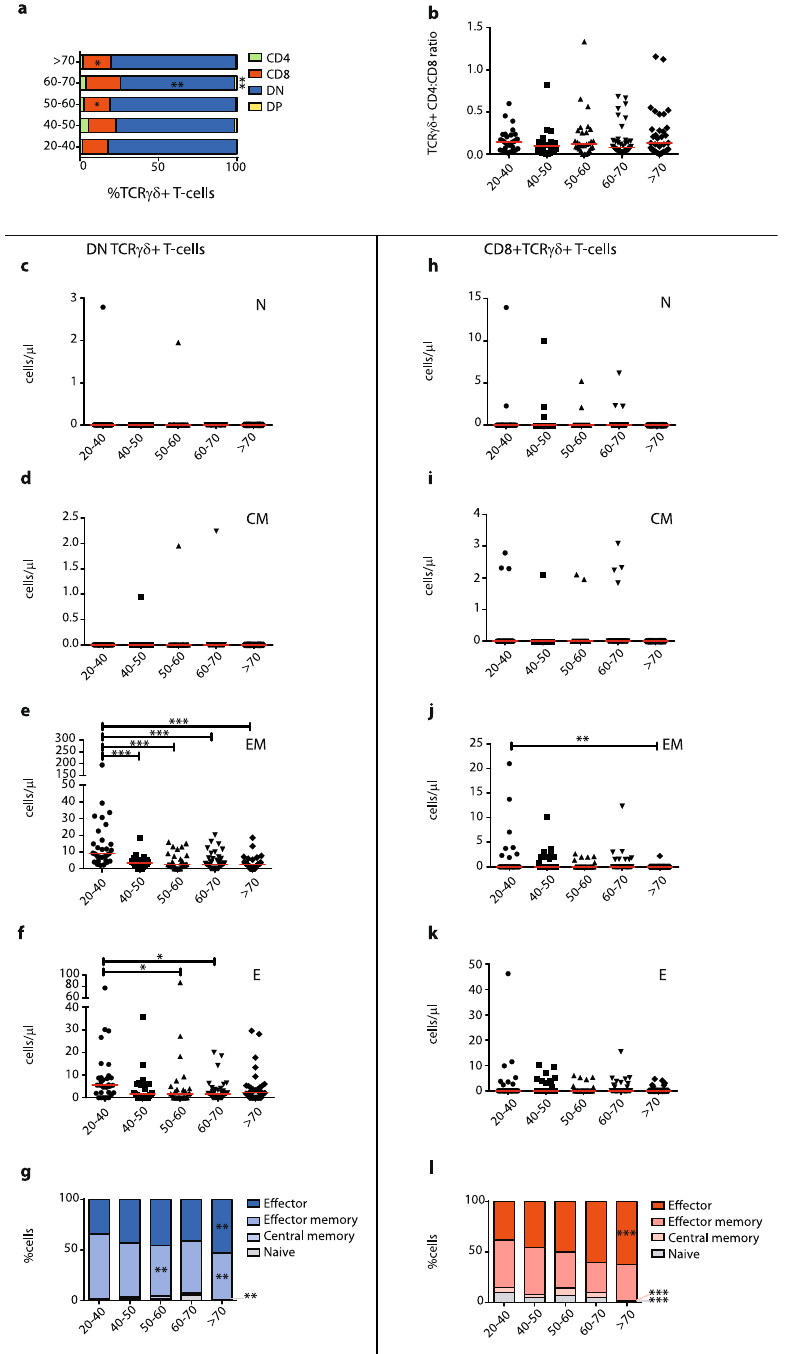
Figure 2. TCR γδ+ T-cell maturation statuses and subset distributions during ageing. ( a ) Relative visualization of CD4 and CD8 single-positive, double-positive (DP, CD4 + CD8 + ) and double-negative (DN, CD4 − CD8 − ) distribution within the total TCR γδ+ T-cell compartment between different age groups. ( b ) CD4:CD8 ratios in total TCR γδ+ T-cell population. ( c ) Absolute numbers of DN naive (CD45RO − CD197 + ), ( d ) central memory (CD45RO + CD197 + ), ( e ) effector memory (CD45RO + CD197 − , Temro) and ( f ) effector (CD45RO − CD197 − , Temra) TCR γδ+ T-cells. ( g ) Relative distributions of maturation subsets of DN TCR γδ+ T-cells depicted in stacked bar plots. ( h ) Absolute numbers of CD8 + naive, ( i ) central memory, ( j ) effector memory and ( k ) effector CD8 + TCR γδ+ T-cells. ( l ) Relative distributions of maturation subsets of CD8 + TCR γδ+ T-cells depicted in stacked bar plots. Ratios and absolute numbers are indicated in scatter plots indicated with the median. Significance was tested by a Kruskal-Wallis test, followed by a post-Dunn’s test for correction for multiple testing. Significance for the Dunn’s test is indicated in the plots: * p < 0.05; ** p < 0.01, *** p <